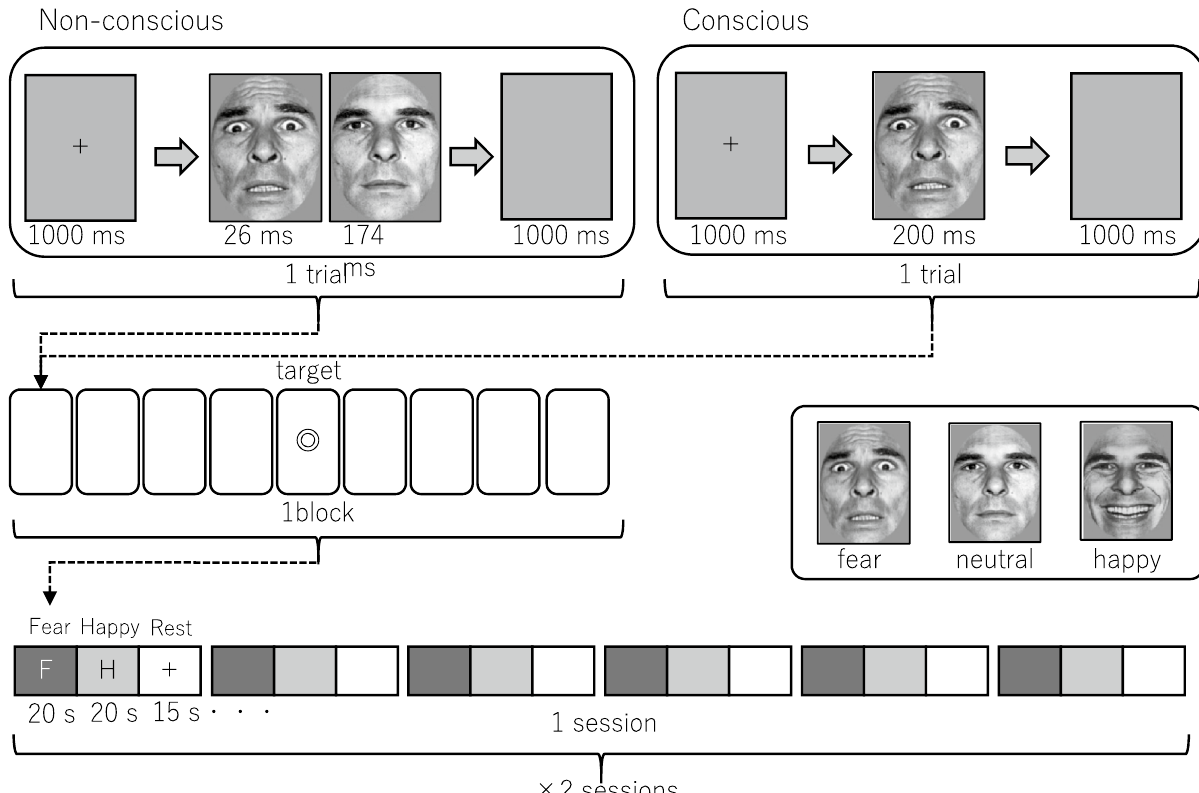
Figure 1. Emotional-face viewing task. Facial pictures depicting fearful, happy, or neutral expressions were used as the stimuli and were presented either non-consciously or consciously. In a non-conscious trial, an emotional image (either fearful, happy, or neutral) was implicitly presented for 26 ms, followed by an explicit presentation of a neutral “masking” face of the same individual as the preceding implicit emotional face (when the implicit face was neutral, the following explicit mask was of a different person of the same sex) for 174 ms. Participants were required to press a button in response to each “target” stimulus to keep themselves awake during the